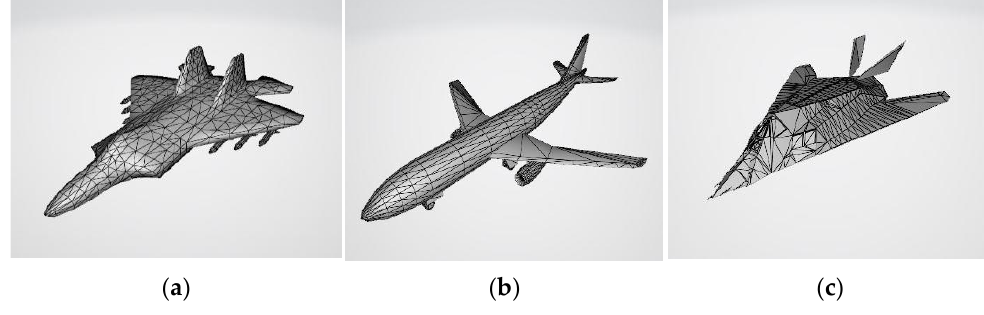
Figure 2. RCS Measurement Model. ( a ) Jet Plane; ( b ) Transport Plane; ( c ) F-117.